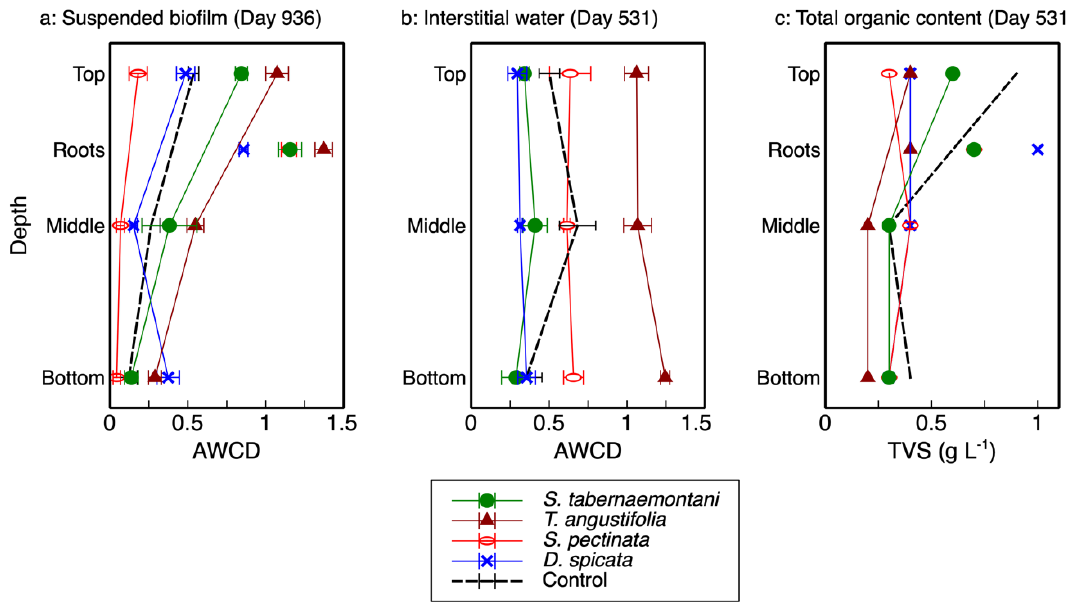
Figure 1. a : Microbial activities for biofilm from each bioreactor at 3 depths and plant roots. b : Microbial activities for interstitial water from each bioreactor at 3 depths (adapted from [1]). c : Total organic content of the suspended solution containing biofilm from wood-chip samples (top, middle and bottom) and plant roots (TVS: total volatile solids and AWCD: average well color development).